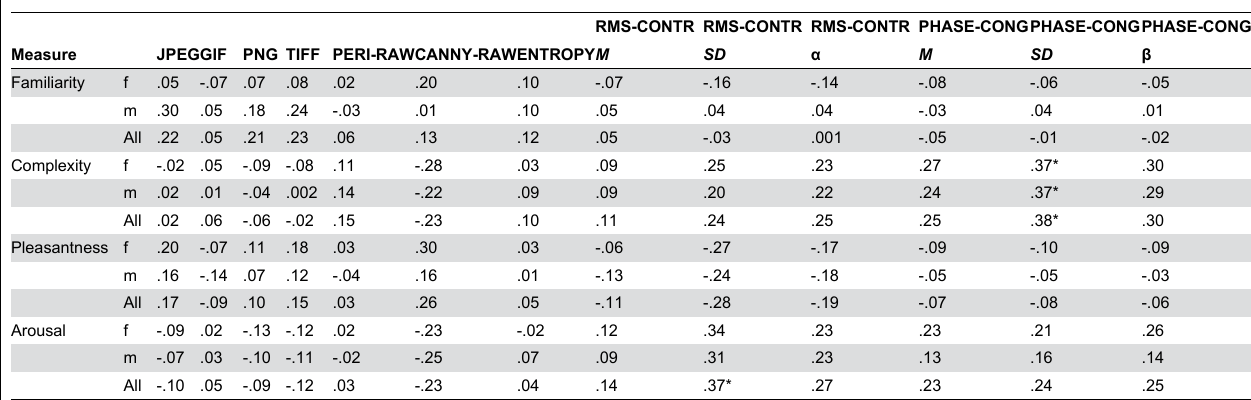
Table 7. Spearman’s rank-order correlations between a set of 13 measures of objective complexity applied to representational paintings (N = 96) and ratings of familiarity, complexity, pleasantness and arousal.